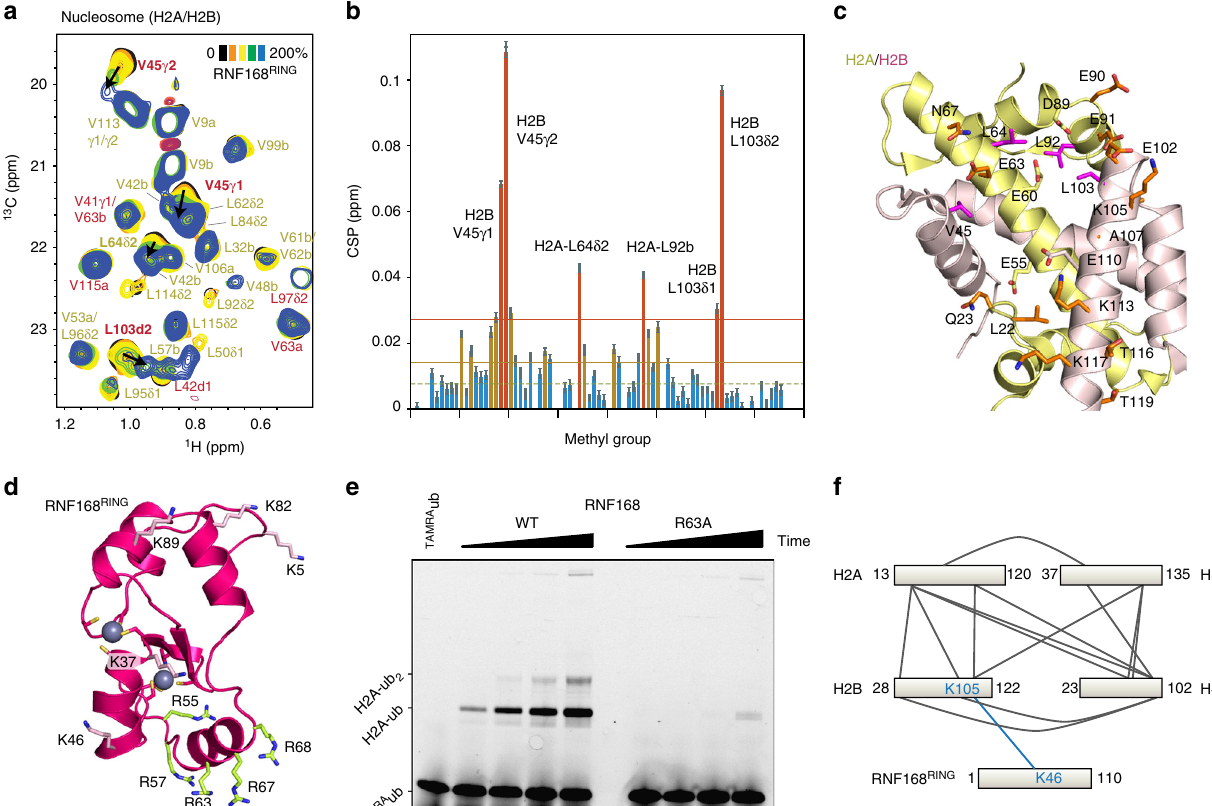
Fig. 2 RNF168 RING binds the nucleosome acidic patch using its Arg-rich helix. a Section of the 2D 1 H- 13 C methyl-TROSY spectrum of the nucleosome with ILV-labeled H2A/H2B with increasing amounts of RNF168 RING added. Color coding indicated. Labels a/b refer to either of the δ 1/ δ 2 Leu or γ 1/ γ 2 Val methyl groups. b Weighted chemical shift perturbation (CSPs) between the spectra of 1:2 and 1:0 nucleosome:RNF168 RING . Residues with CSPs that are one (two) standard deviations larger than the 10% trimmed mean are highlighted in yellow (red) and labeled. Error bars are s.d. based on 1 ppb standard error in peak position in 1 H and 13 C dimension. c The RNF168 binding surface as de fi ned by NMR (shown as sticks, color coded in orange/magenta for dimer/nucleosome data). Side chains of other acidic patch residues are shown as sticks, color coded in yellow for H2A and light red for H2B. d Crystal structure of the RNF168 RING domain with Arg residues of the basic-helix highlighted as yellow sticks. Lysine residues are shown as sticks and labeled, Zn atoms shown as spheres, coordinating residues as sticks. e Nucleosome ubiquitination by either wild-type (WT) or R63A mutant RNF168 RING . Fluorescent TAMRA-labeled ubiquitin was used to detect ubiquitinated species. Samples were resolved using SDS-PAGE. For both wild-type and mutant time points were taken at 5, 15, 30 and 60 min of incubation of the reaction mixture. Molecular size of mono- and di-ubiquitinated H2A is indicated. f Schematic representation of inter-histone crosslinks (gray; for rigid histone core only) and intermolecular RNF168-nucleosome crosslinks (blue) obtained from XL-MS. Source data are provided as a Source Data fi